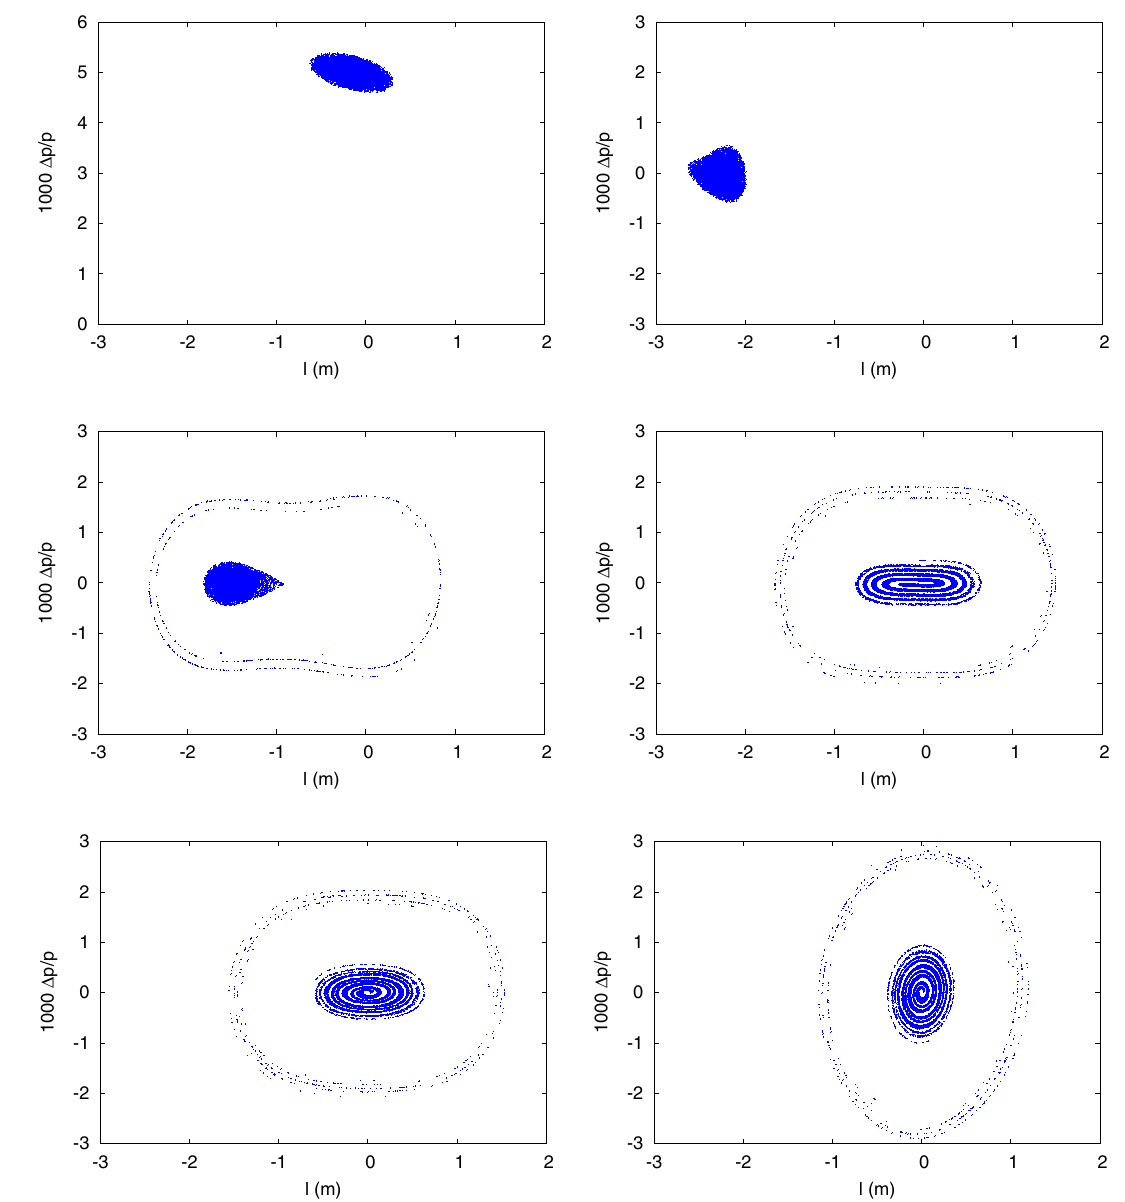
FIG. 43. Fresh helium beam in the longitudinal phase space after entering into the decay ring, after one quarter turn, while the asymmetric merging, while the symmetric merging, at the end of the symmetric merging, at the end of the